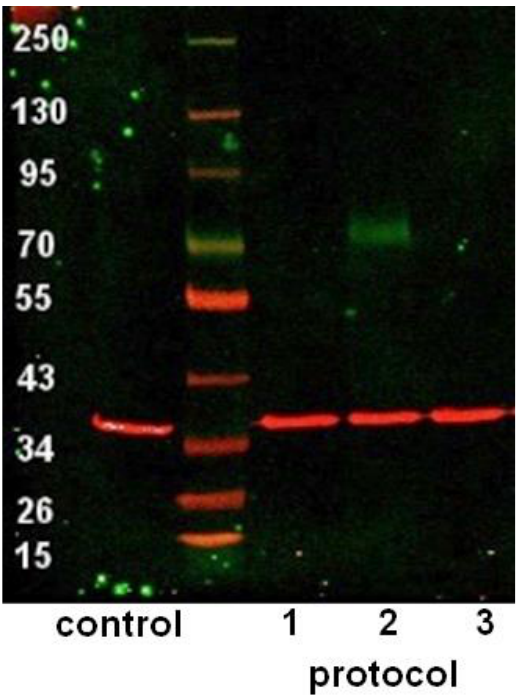
Figure 3. Western blot with proteins isolated from differentiated ADSCs. Expression of p75 (displayed in green) can be observed after differentiation with Protocol 2 only. GAPDH served as loading control (displayed in red).